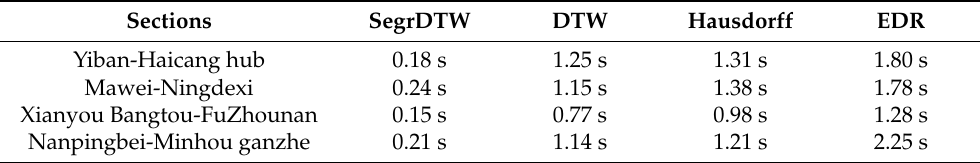
Table 3. The algorithm retrieval times.